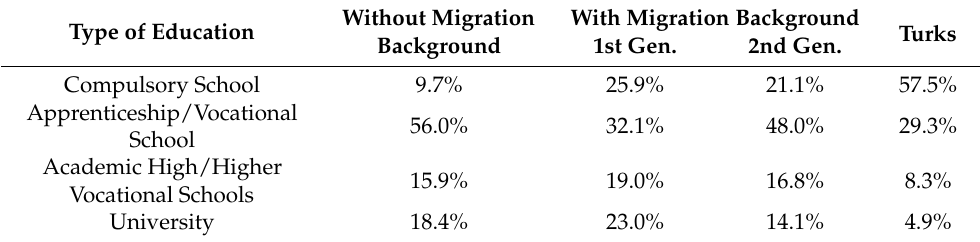
Table 1. Highest Educational Background in Austria by Migration Background 1